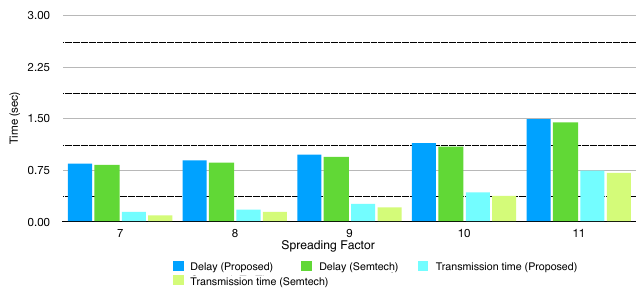
Figure 12. Delay and transmission time (16 byte packet).